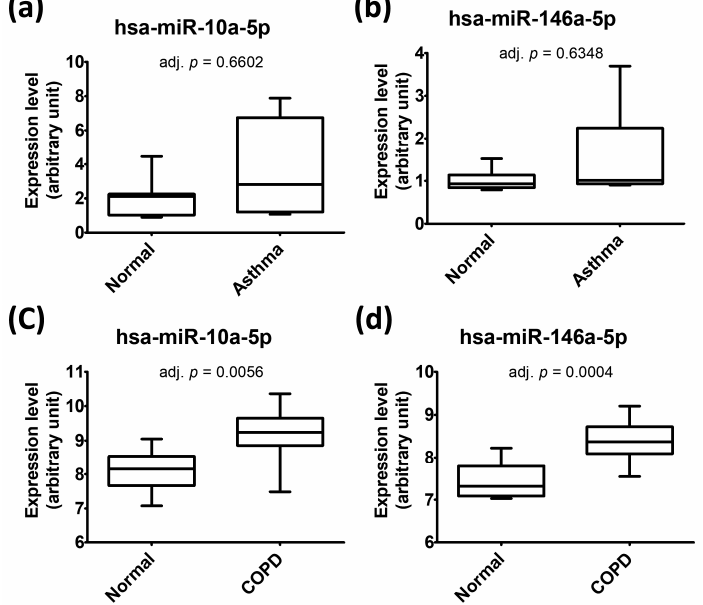
Figure 2. The levels of miR-10a-5p ( a , c ) and miR-146a-5p ( b , d ) in human bronchial epithelial cells obtained from GSE25230 ( a , b ) and GSE38974 ( c , d ). The data form Gene Expression Omnibus (GEO) database were analyzed with GEO2R. The p values adjusted with method by Benjamini and Hochberg (false discovery rate) (adj. p ) were shown.